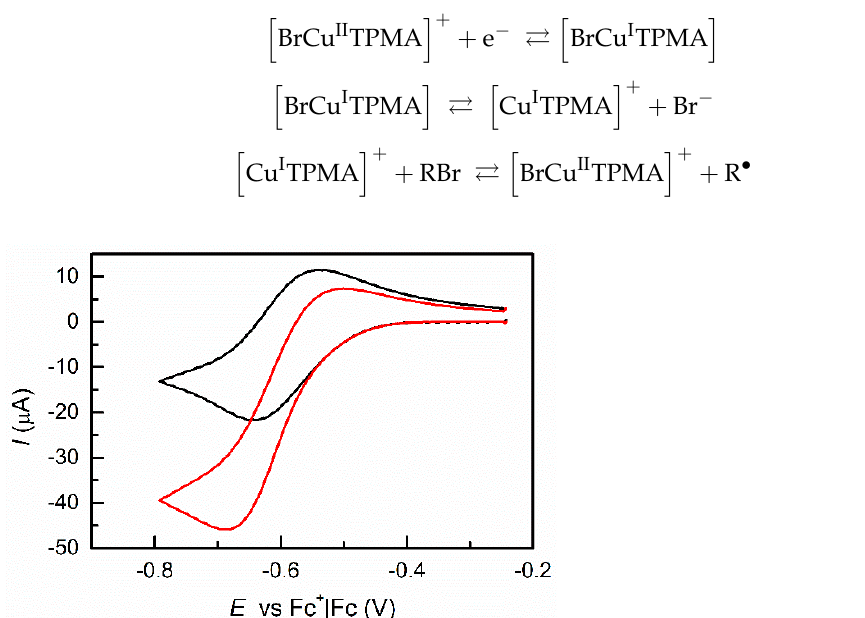
Figure 2. Cyclic voltammetry of 10 − 3 M [BrCu II TPMA] + in DMF/styrene (50:50, v/v) + 0.1 M Et 4 NBF 4 in the absence ( ▬ ) and presence of 1.5 × 10 − 2 M EBiB ( ▬ ), recorded on a GC disk electrode at 0.2 V/s and T = 80 °C.